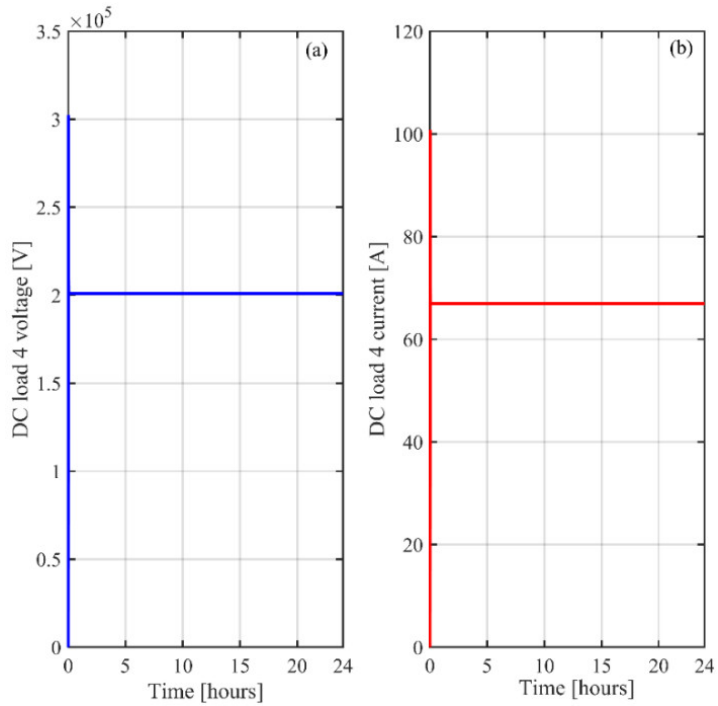
Figure 18. Voltage ( a ) and current ( b ) of the HVDC distribution at DC load 4.